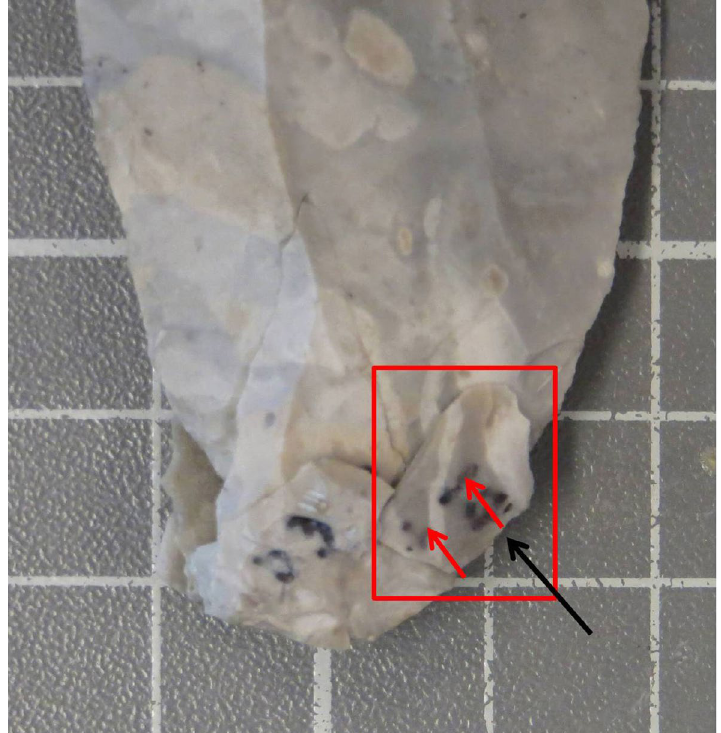
Figure 6. Blade-point 4.2, broken flake d1+ with red arrows indicating direction of previous removals and the black arrow the direction of the flake removal blow (photograph by the author). Gridlines on this image are 10mm